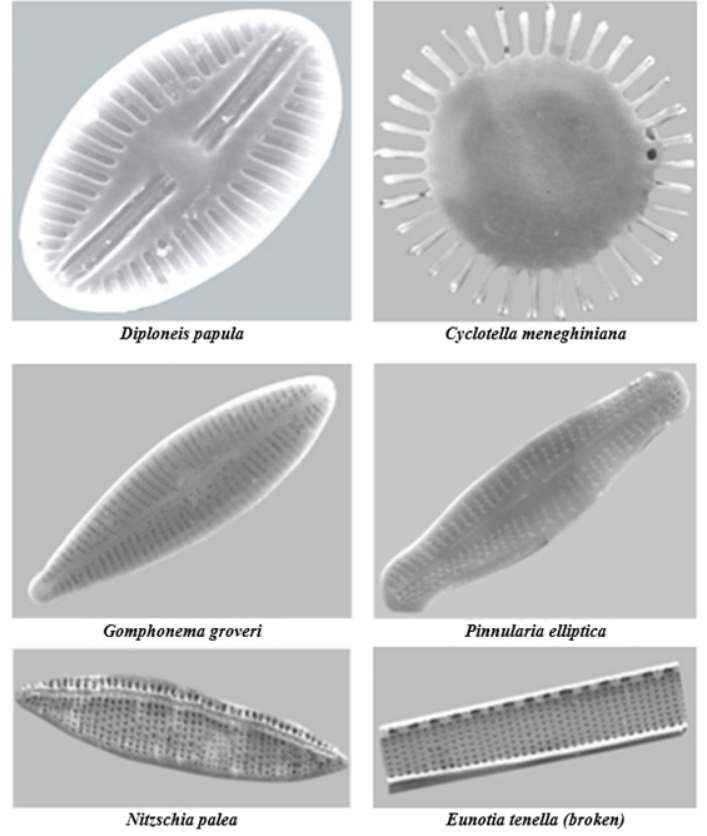
Figure 6. Photomicrographs of diatoms through Scanning Electron Microscope. Reproduce with permission from [101].